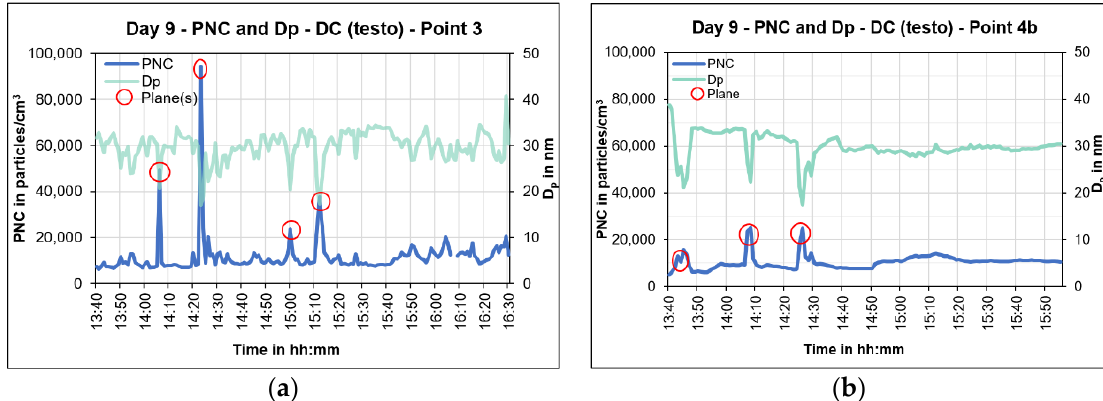
Figure 12. Day 9 simultaneous UFP measurements at ( a ) point 3 and ( b ) point 4b.